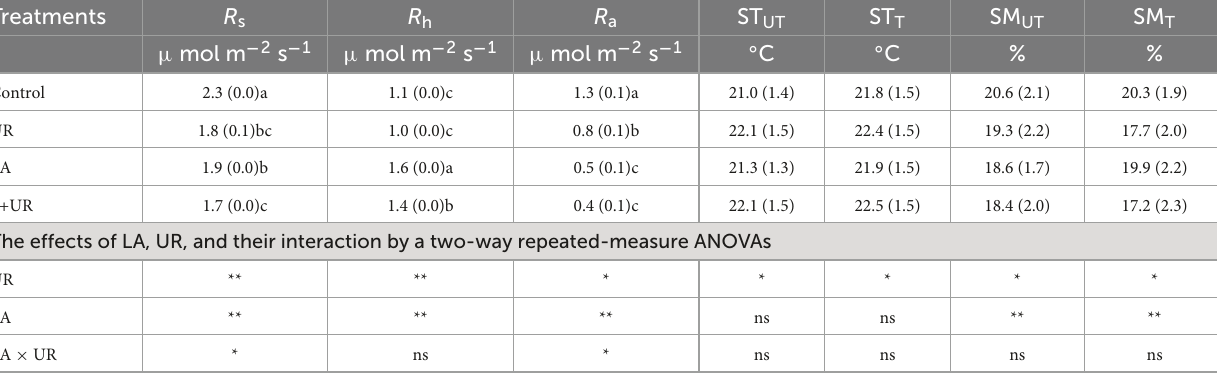
TABLE 1 Effects of lime application (LA), understory removal (UR), and their interactions (LA × UR) on soil respiration ( R s , R h , and R a ), soil temperature (ST), and soil moisture (SM) in a southern Chinese Eucalyptus plantation. Treatments R s R h R a ST UT